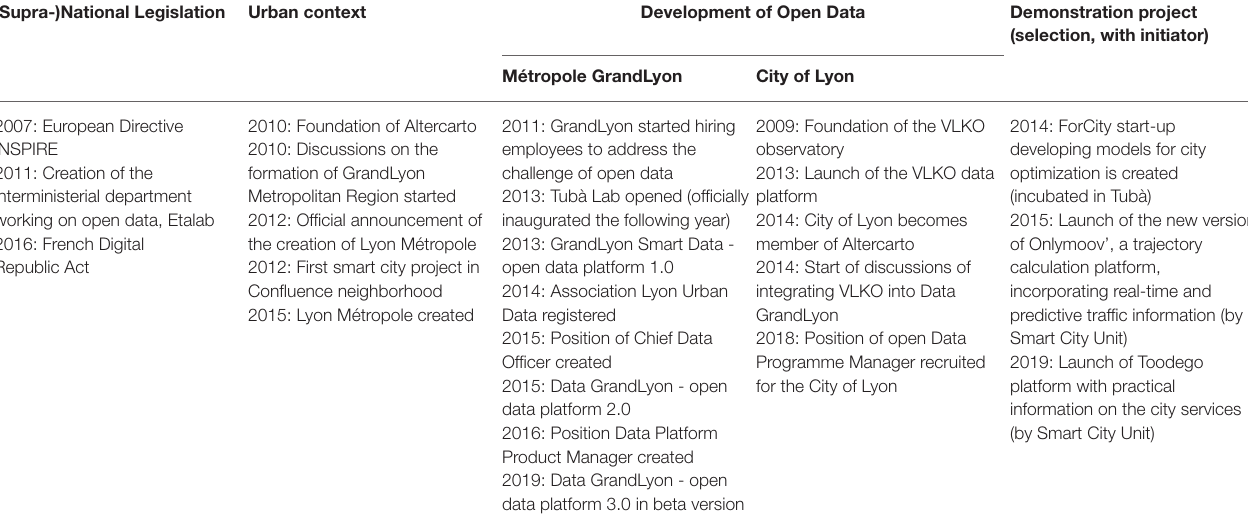
TABLE 4 | Development of Open Data in Lyon (section Metropolitan Hub for Economic Innovation: Data